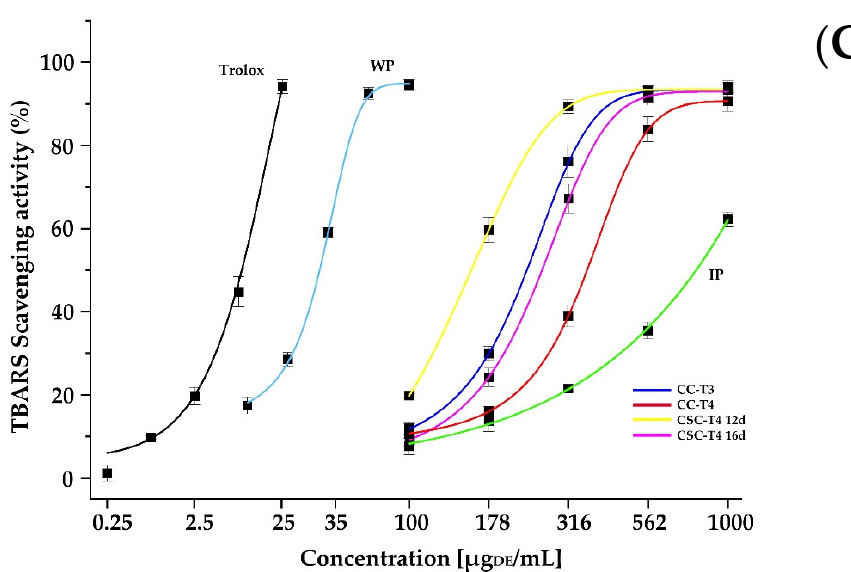
Figure 4. Antioxidant capacity of extracts from A. pichichensis and its cell cultures against ( A ) ABTS, ( B ) DPPH radicals and ( C ) TBARS lipid peroxidation.